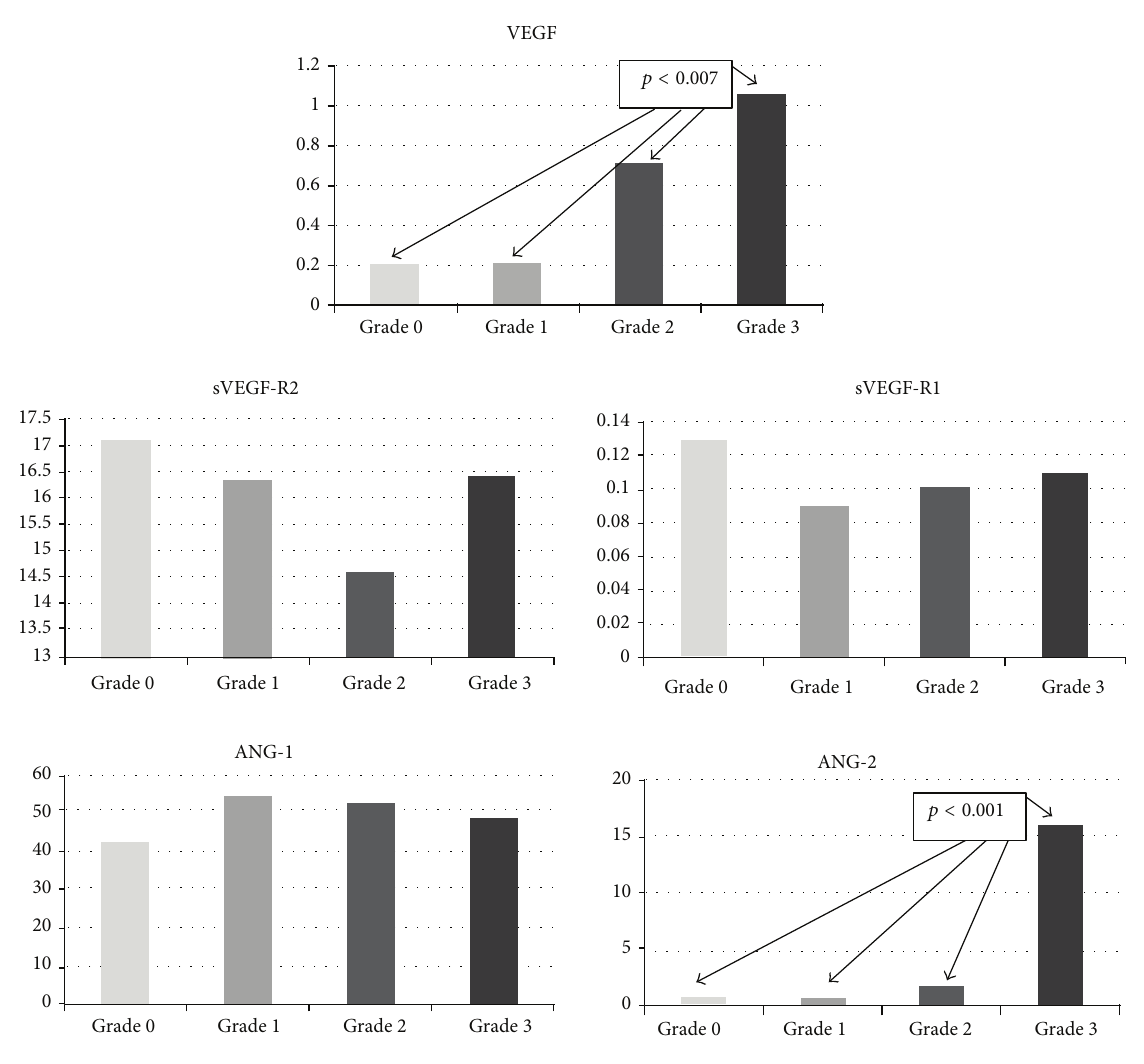
Figure 2: Ultrasound joint vascularization scale and serum levels of angiogenic proteins in JIA children. Joint vascularization scale: grade 0 = no signs of vascularization, 1 = mild (presence of single/vessel dots), 2 = moderate (presence of confluent vessel dots in less than half of the synovial area), and 3 = marked (presence of confluent vessel dots in more than half of the synovial